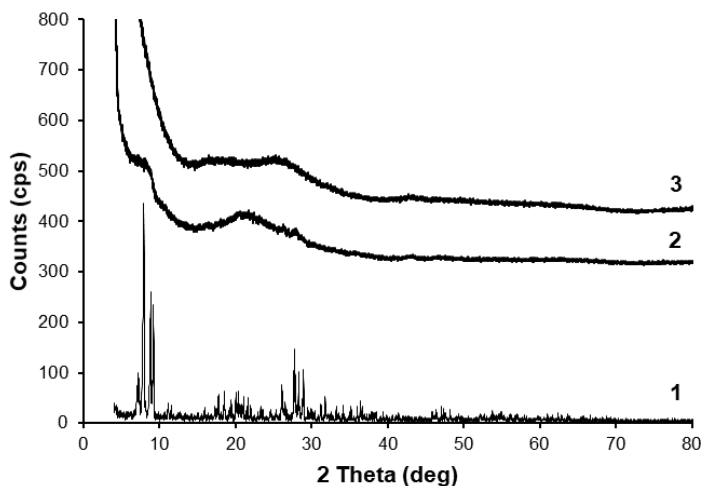
Figure 2. XRD patterns (CuKα radiation, λ = 1.542 Å) for bulk HPA-1 (1), 15%HPA-1/SiO 2 (2) and 15%HPA-1/C (3).